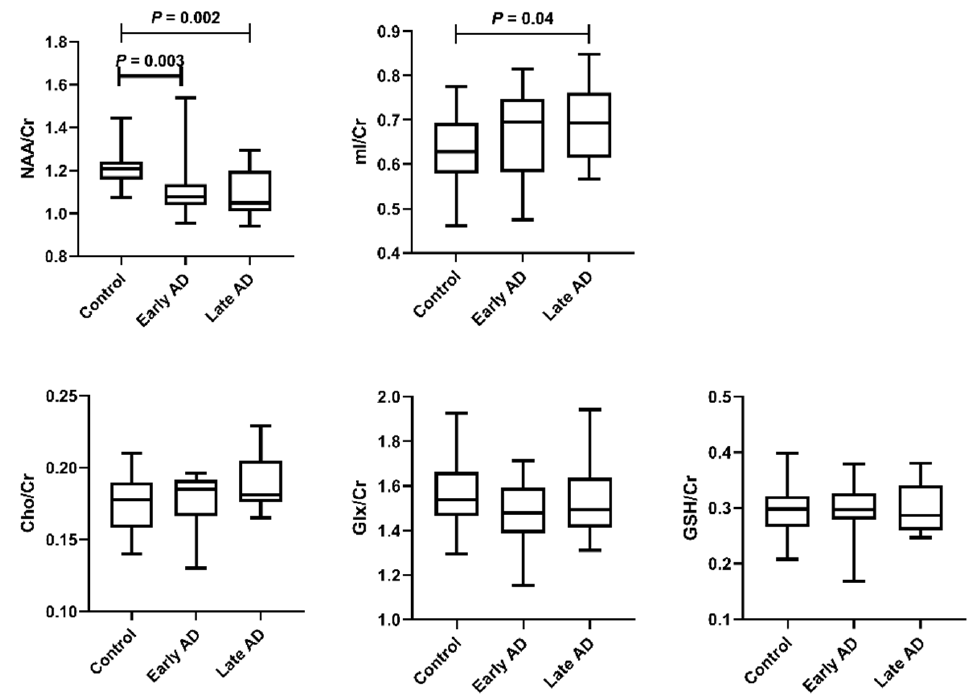
Figure 2. Comparison of MRS metabolite levels across groups. The bars show the median and inter-quartile range. NAA/Cr was significantly different between the control and early AD groups and between the control and late AD groups. mI/Cr was significantly different between the control and late AD groups.